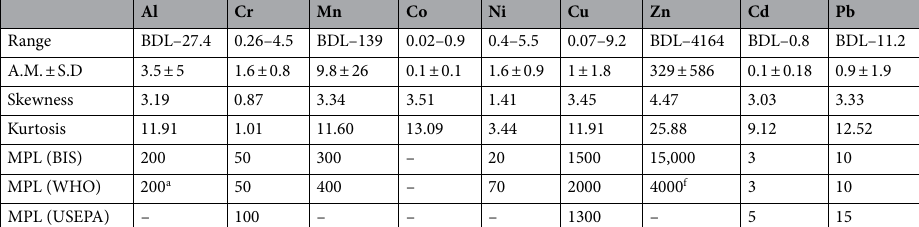
Table 7. Statistical values of observed HM concentrations (µg l −1 ) in the study area (N = 72). f Legal limit for water intended for the consumption of